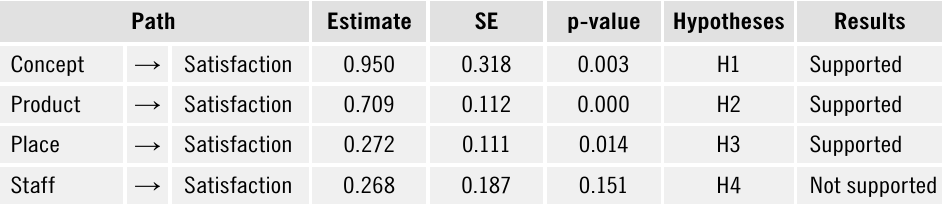
Table 5. Hypotheses verification results based on structural equation modeling